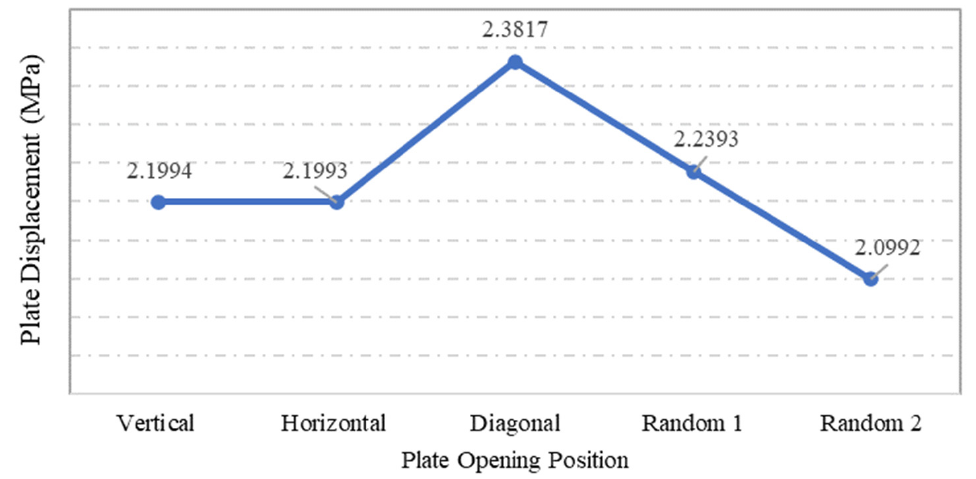
Figure 21. Influence of plate opening positions on plate maximum displacement.